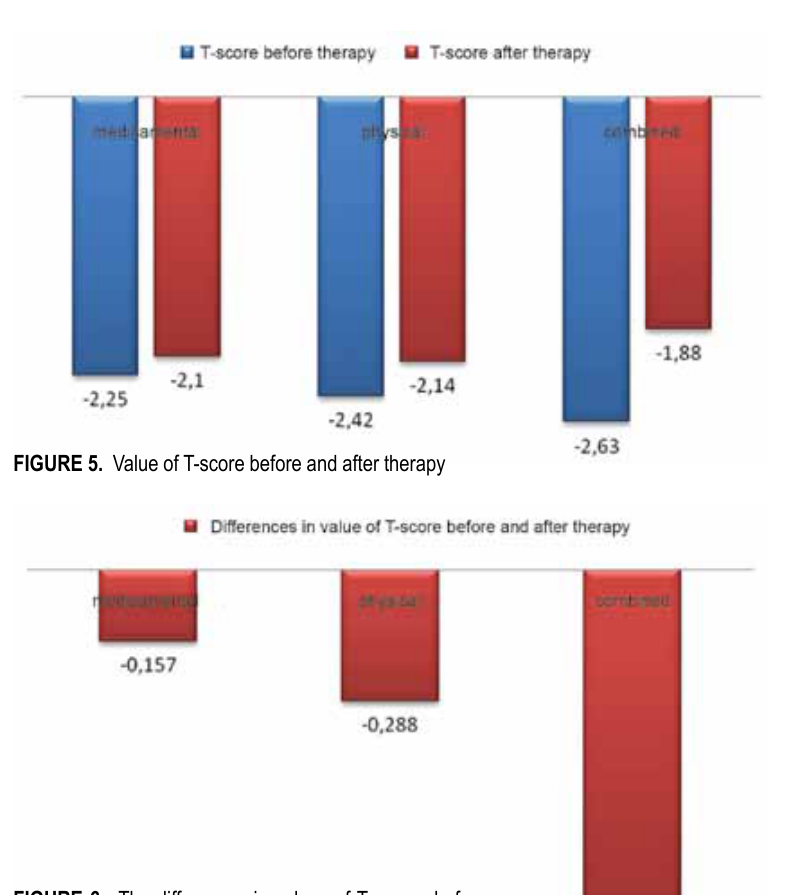
FIGURE 6. the differences in values of t-scores before and after